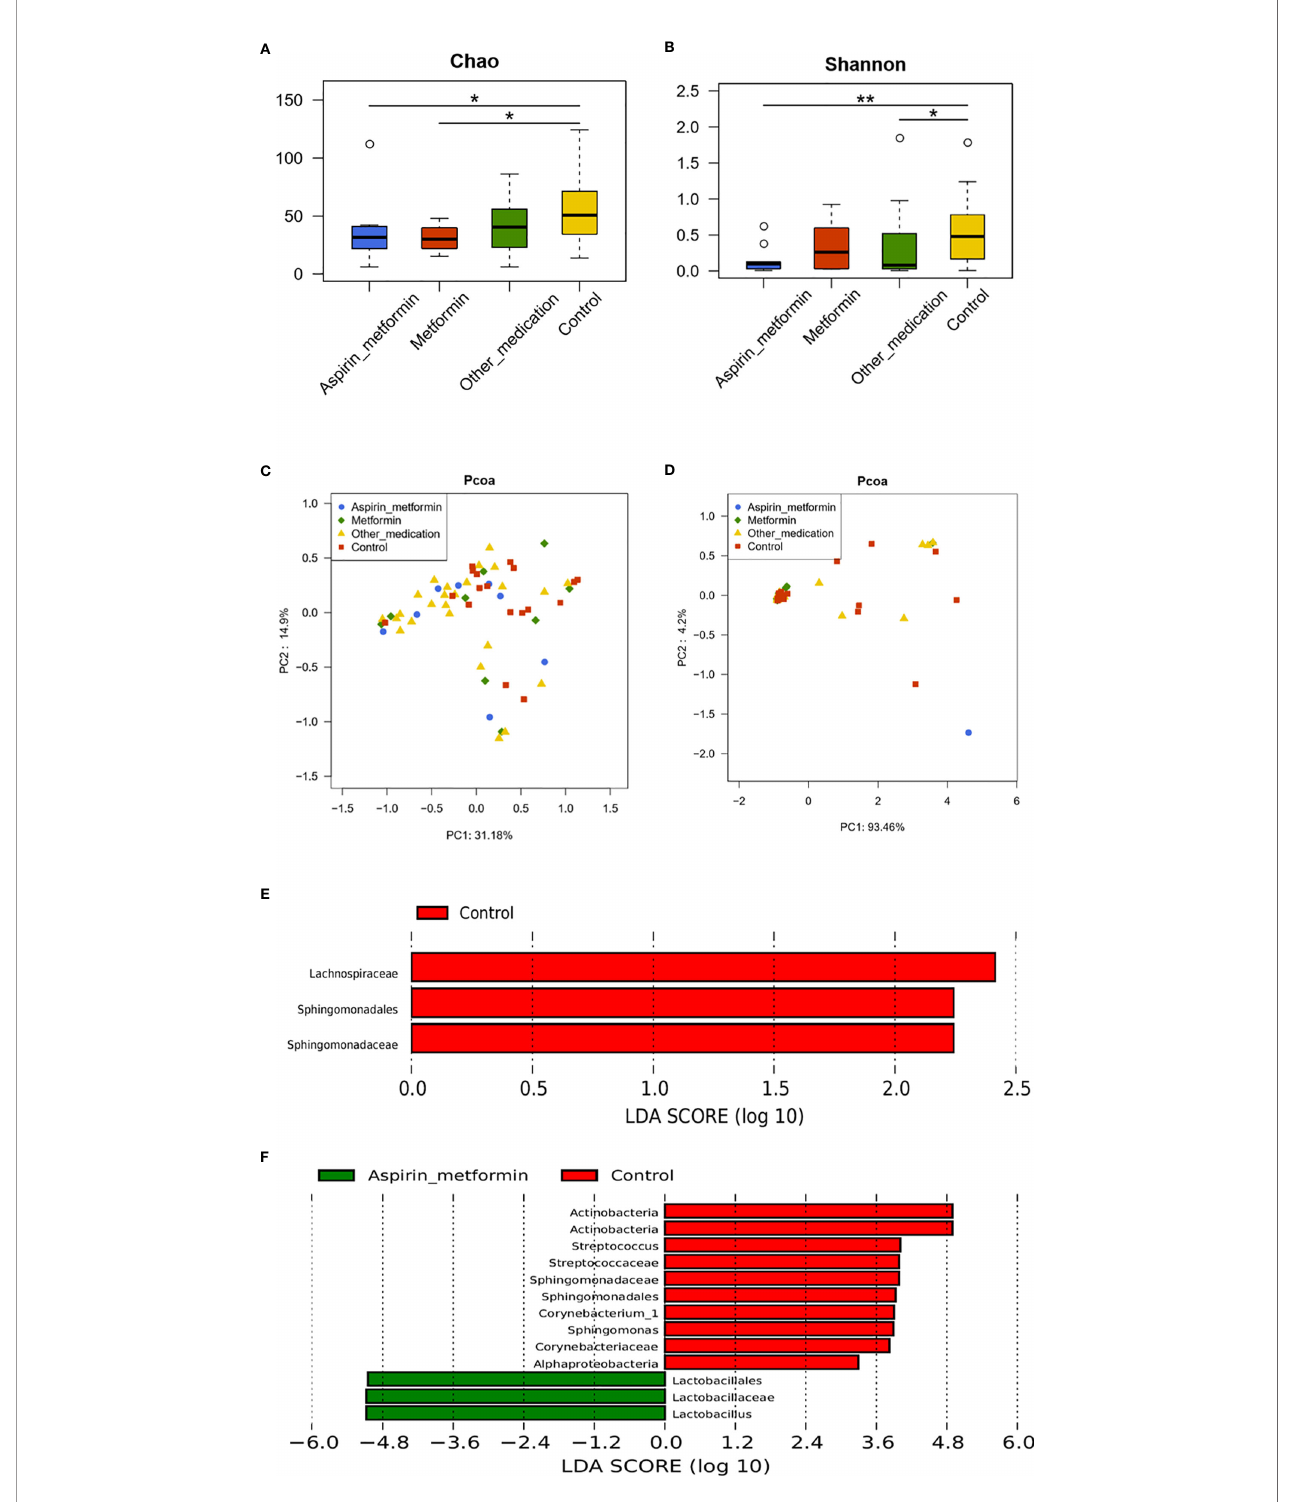
FIGURE 4 | The effect of different medications on vaginal microbiota. The diversity of the vaginal microbiota in each group is shown by the Chao index (A) , Shannon – Wiener index (B) , and principal coordinate analysis (PCoA) plot created based on the unweighted (C) and weighted (D) UniFrac distances. (E) Differentially abundant vaginal taxa detected using LDA in samples taken from the metformin and control groups. (F) Differentially abundant taxa detected in patients who received metformin combined with aspirin and controls. (A, B) P values were calculated using the one-sided Wilcoxon rank-sum tests. * p < 0.05 and ** p <